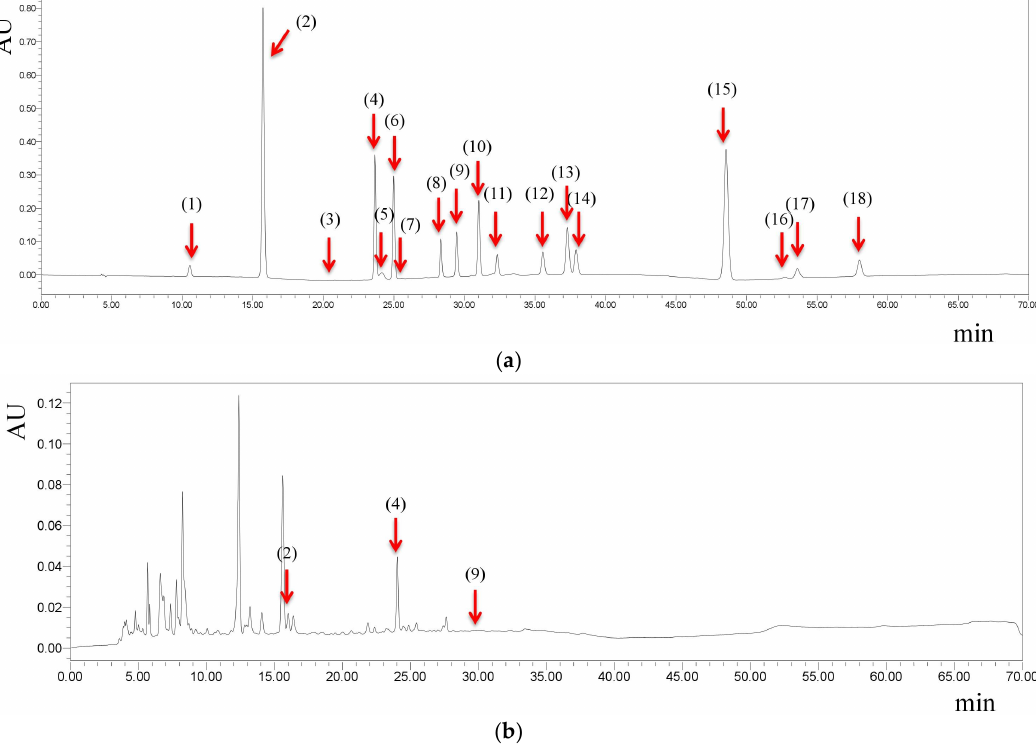
Figure 1. The chromatograms of phenolic compound standards ( a ) and apple vinegar (Zi Lin) ( b ) under 254 nm. Peak identification, retention time and maximum absorption: (1) gallic acid, 10.543 min, 271.3 nm; (2) protocatechuic acid, 15.723 min, 259.4 nm; (3) gallo catechin, 20.821 min, 270.1 nm;